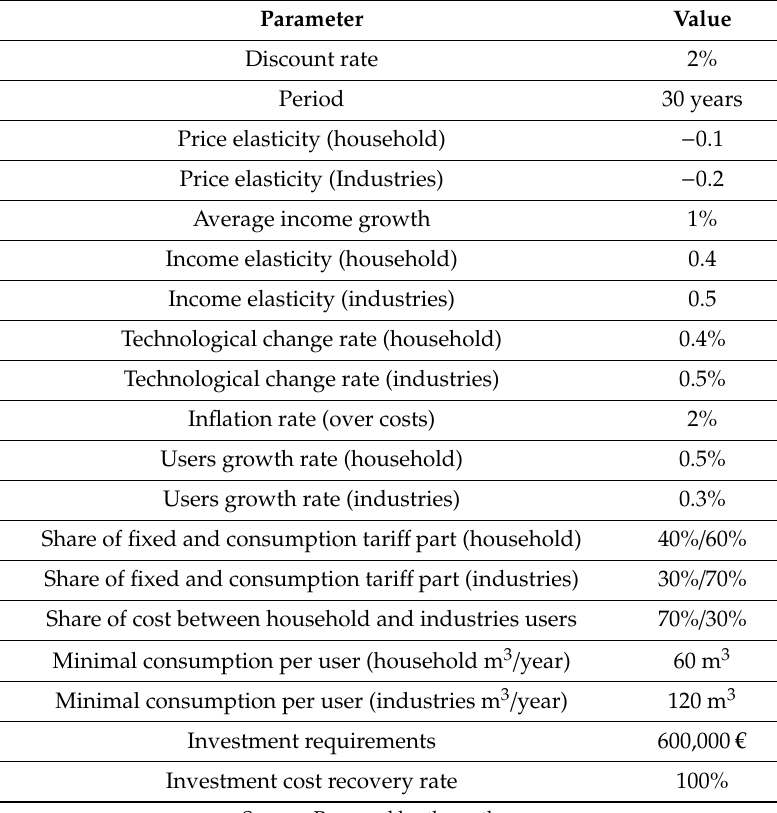
Table 1. Demand and water prices parameter